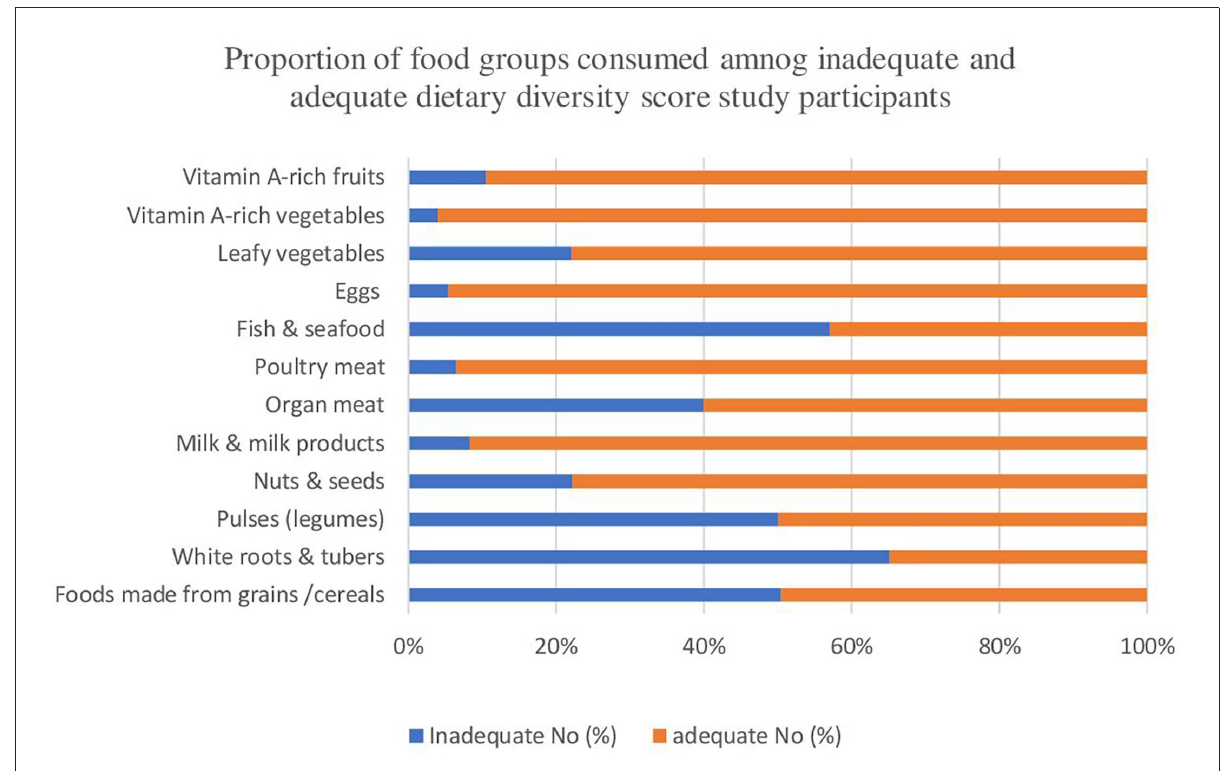
FIGURE2 Revealed proportion of food groups consumed by diet diversity and non-diet diversity study participants in the east Gojjam zone, northwest Ethiopia,